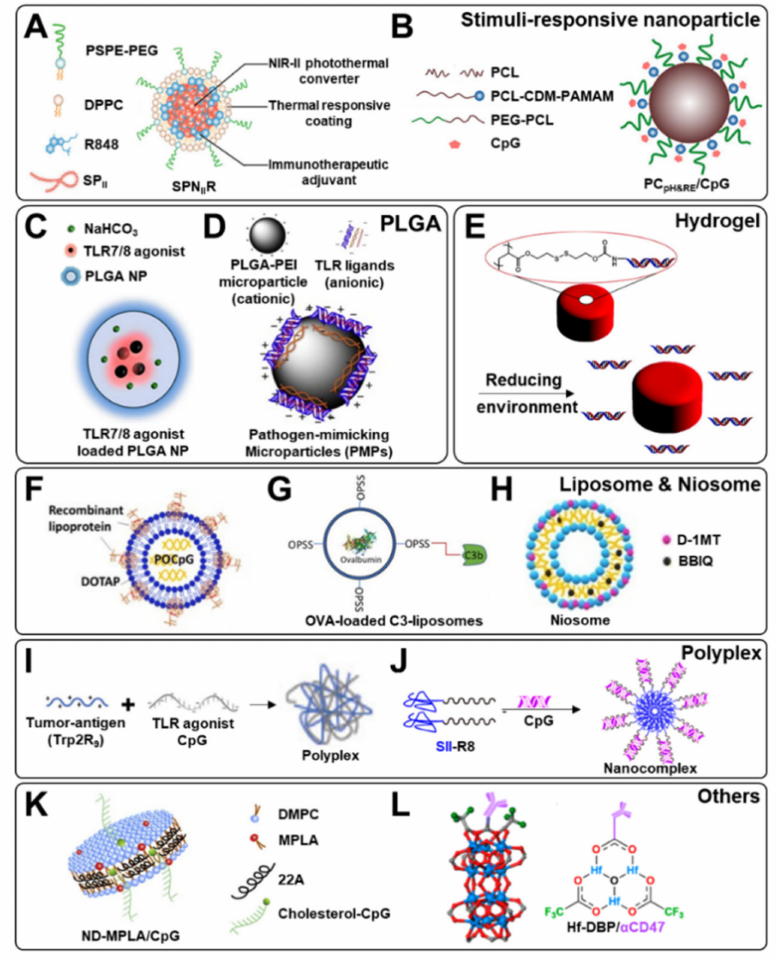
Figure 1. Delivery of TLR agonists using various platforms. ( A , B ) Exogenous TLR agonist delivery via stimuli-responsive vehicles/platforms could effectively release the cargos at the target tumor, and synergistically active release could be obtained with other treatments (e.g., PTT), (( A ) reproduced with permission from ref. [34], 2021 Wiley Online Library; ( B ) reproduced with permission from ref. [35]. 2020 American Chemical Society), ( C , D ) PLGA nanoparticle-mediated delivery (( C ) reproduced with permission from ref. [36]. 2020 American Chemical Society; ( D ) reproduced with permission from ref. [37]. 2014 Elsevier) ( E ) PRINT hydrogel for local tumor delivery of CpG (Reproduced with permission from ref. [38]. 2012 American Chemical Society), ( F – H ) Liposome/niosome for the facilitated encapsulation of TLR agonists and specific targeting efficacy (( F ) reproduced with permission from ref. [39]. 2020 Multidisciplinary Digital Publishing Institute; ( G ) reproduced with permission from ref. [40]. 2019 Elsevier; ( H ) reproduced with permission from ref. [41]. 2020 Elsevier), ( I , J ) polyplex-type platform for RNA/DNA types of TLR agonists (( I ) reproduced with permission from ref. [42], 2020 Frontiers; ( J ) reproduced with permission from ref. [43]. 2020 Elsevier), ( K ) Synthetic high-density lipoprotein nanodiscs or ( L ) metal–organic framework could be also applied (( K ) reproduced with permission from ref. [44]. 2018 Elsevier; ( L ) reproduced with permission from ref. [45]. 2020 American Chemical